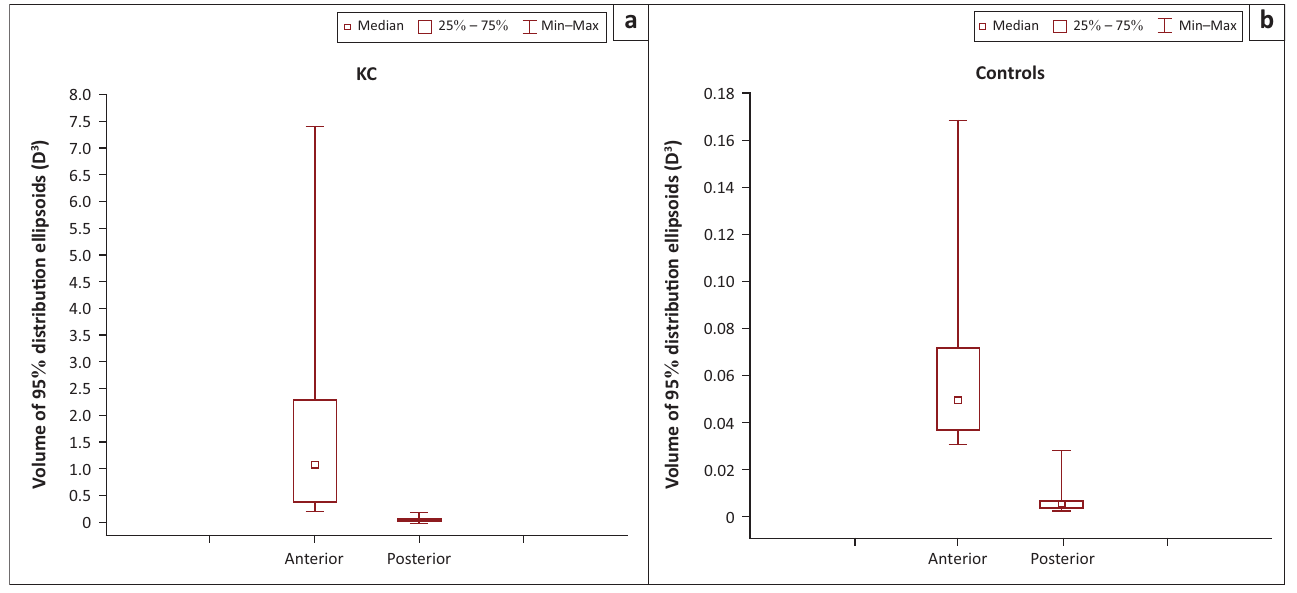
FIGURE 2: Box-and-whisker plots for 95 % distribution ellipsoid volumes (D 3 ) for (a) eyes with keratoconus ( n = 28) and (b) control eyes ( n = 28) eyes for anterior and posterior central corneal power. Take note of the difference in the scale for the plots. TABLE 3: Descriptive statistics for the box-and-whisker plots in Figure 2 for 95 % distribution ellipsoid volumes. Units are D 3 throughout and all samples consisted of 28 eyes. Standard deviations and quartile deviations are included.